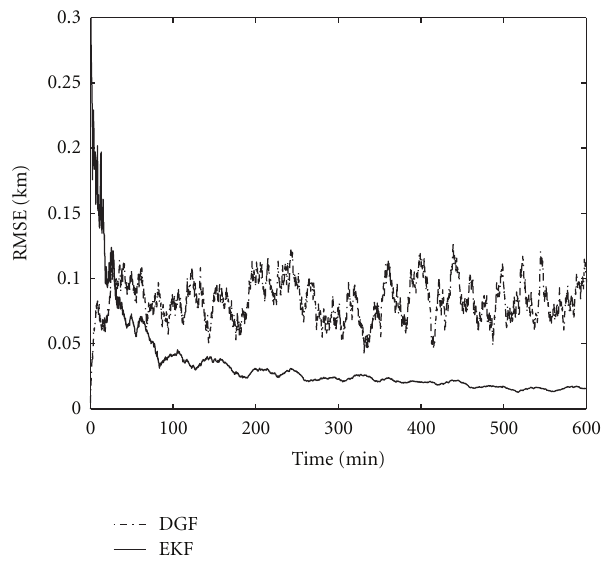
Figure 9: RMSE comparison (Stable